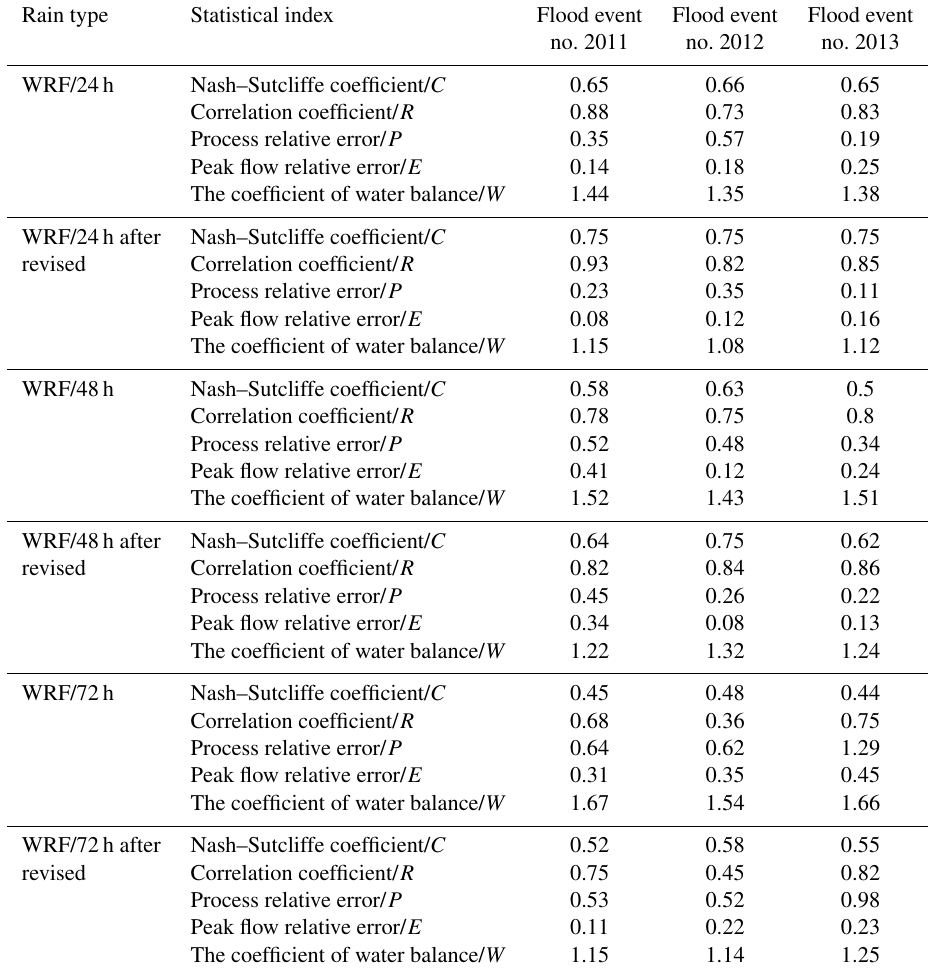
Table 2. Evaluation indices of simulated flood events with the post-processed WRF QPF. Rain